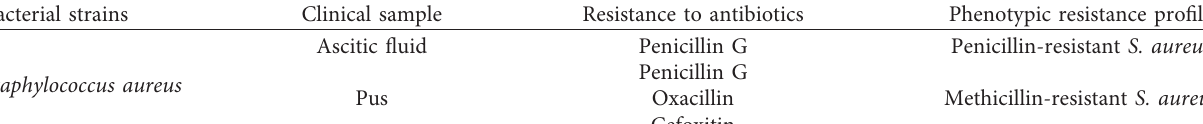
Table 1: Phenotypic resistance profile of clinical isolates bacterial